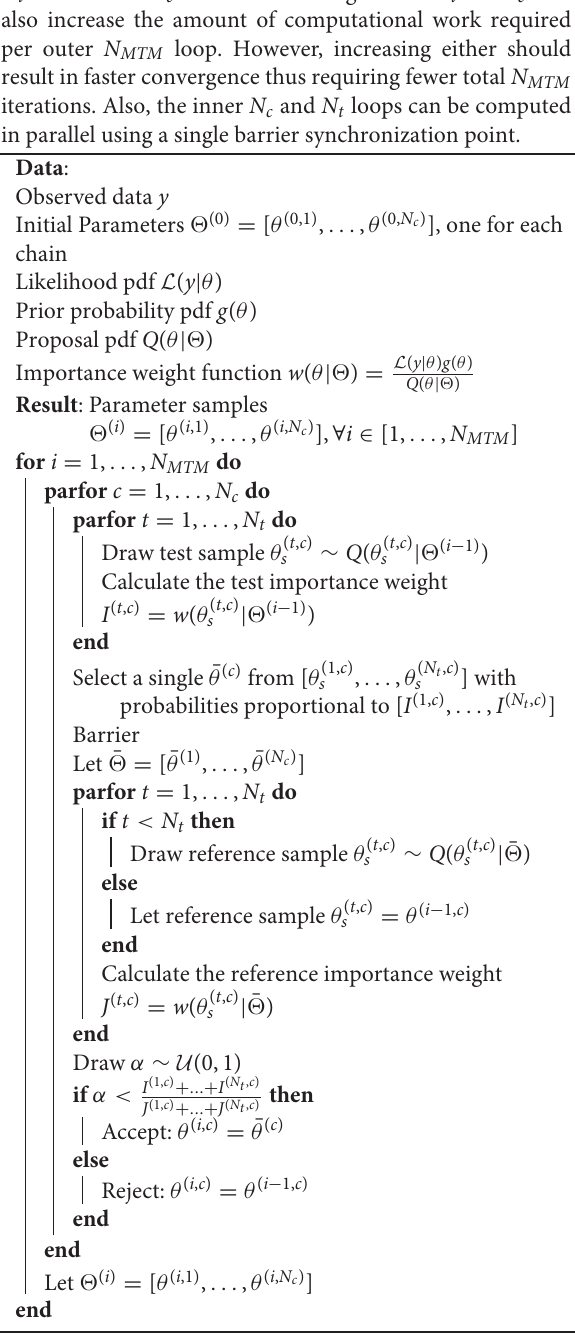
Algorithm 1: Variation of the Multiple-Try Metropolis Algorithm with N t tries and N c chains. It is identical